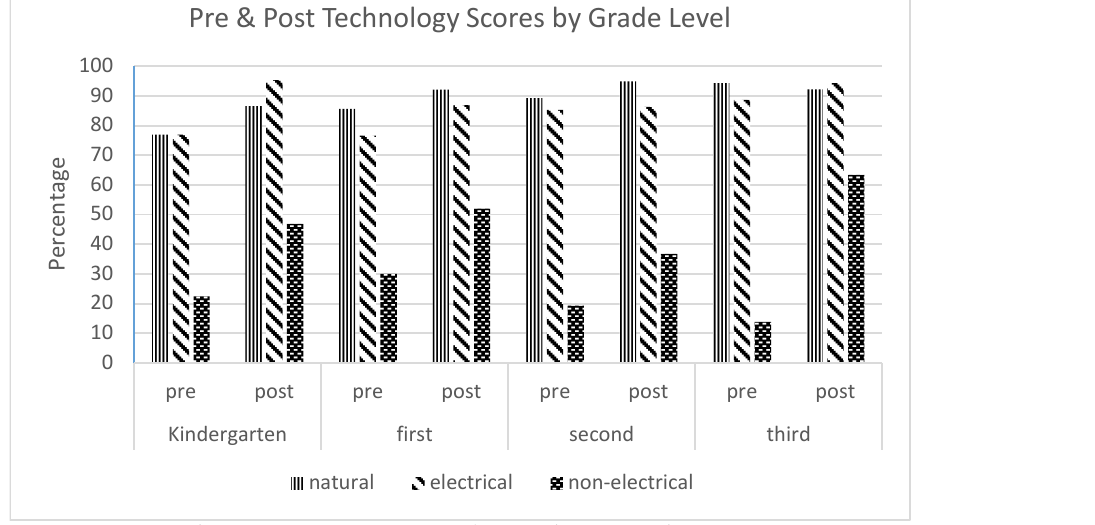
Figure 4. Pre and post Technology Scores by Grade level and category type Table 8. Normalized Gain Scores (<g>) by grade and technology